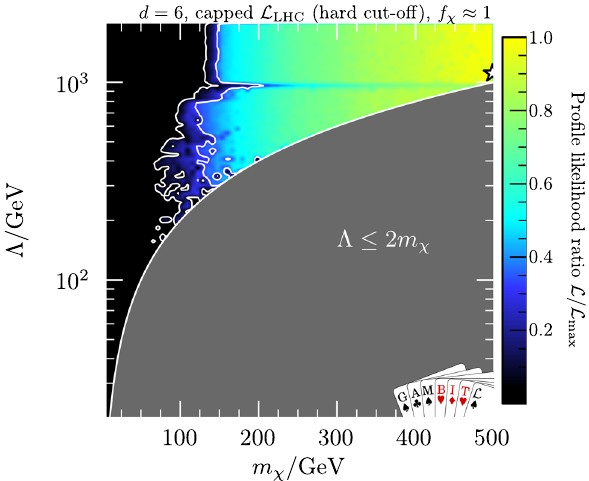
Fig. 5 Same as the right panel of Fig. 2 but requiring the DM relic density to be saturated (rather than imposing an upper bound only)